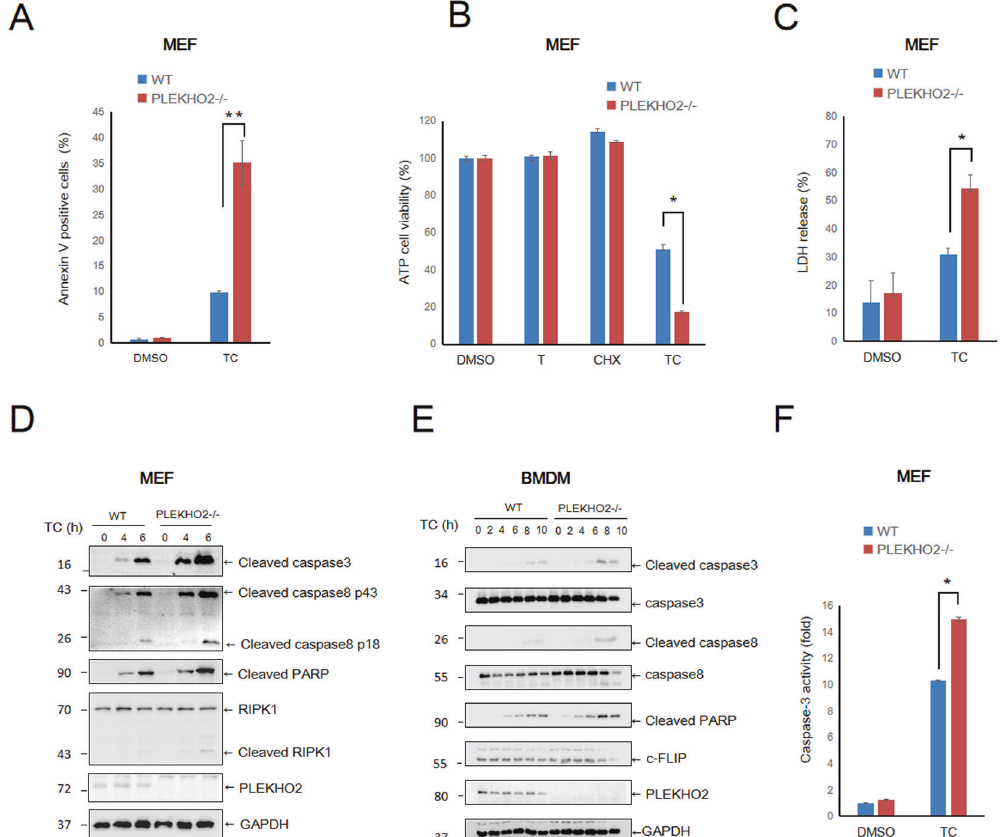
Fig. 1 PLEKHO2 de fi ciency sensitizes cells to TNF α /CHX induced apoptosis. A WT and PLKEHO2 − / − MEFs were treated with DMSO or murine TNF α (20 ng/mL) and cycloheximide (CHX) (10 μ g/mL) for 8 h and analyzed by fl ow cytometry for a percentage of cells staining positive for annexin V staining. B WT and PLKEHO2 − / − MEFs treated as indicated (TC, TNF α 20 ng/mL plus CHX 10 μ g/mL) for 8 h, cell viability was measured by ATP level. C WT and PLKEHO2 − / − MEFs treated with DMSO or TNF α plus CHX (TC) as B for 8 h. Cytotoxicity was measured by LDH release. D WT and PLKEHO2 − / − MEFs were treated with TNF α (20 ng/mL) and cycloheximide (CHX) (10 μ g/mL) for indicated periods of time. Cell lysates were probed with indicated antibodies. E WT and PLKEHO2 − / − BMDMs were treated with TNF α (20 ng/mL) and cycloheximide (CHX) (10 μ g/mL) for indicated periods of time. Cell lysates were probed with indicated antibodies. F WT and PLKEHO2 − / − MEFs treated with DMSO or TNF α plus CHX (TC) for 8 h, Caspase-3 activity was measured by Caspase-Glo 3 assay. Results are representative of at least three independent